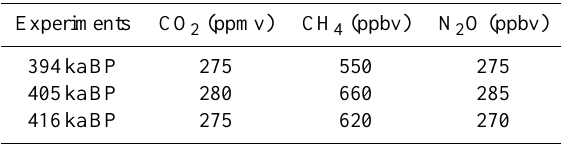
Table 2. Greenhouse gas concentrations used in forcing the CCSM3 experiments (Siegenthaler et al., 2005; Schilt et al., 2010; Lourergue et al., 2008). See also Fig.